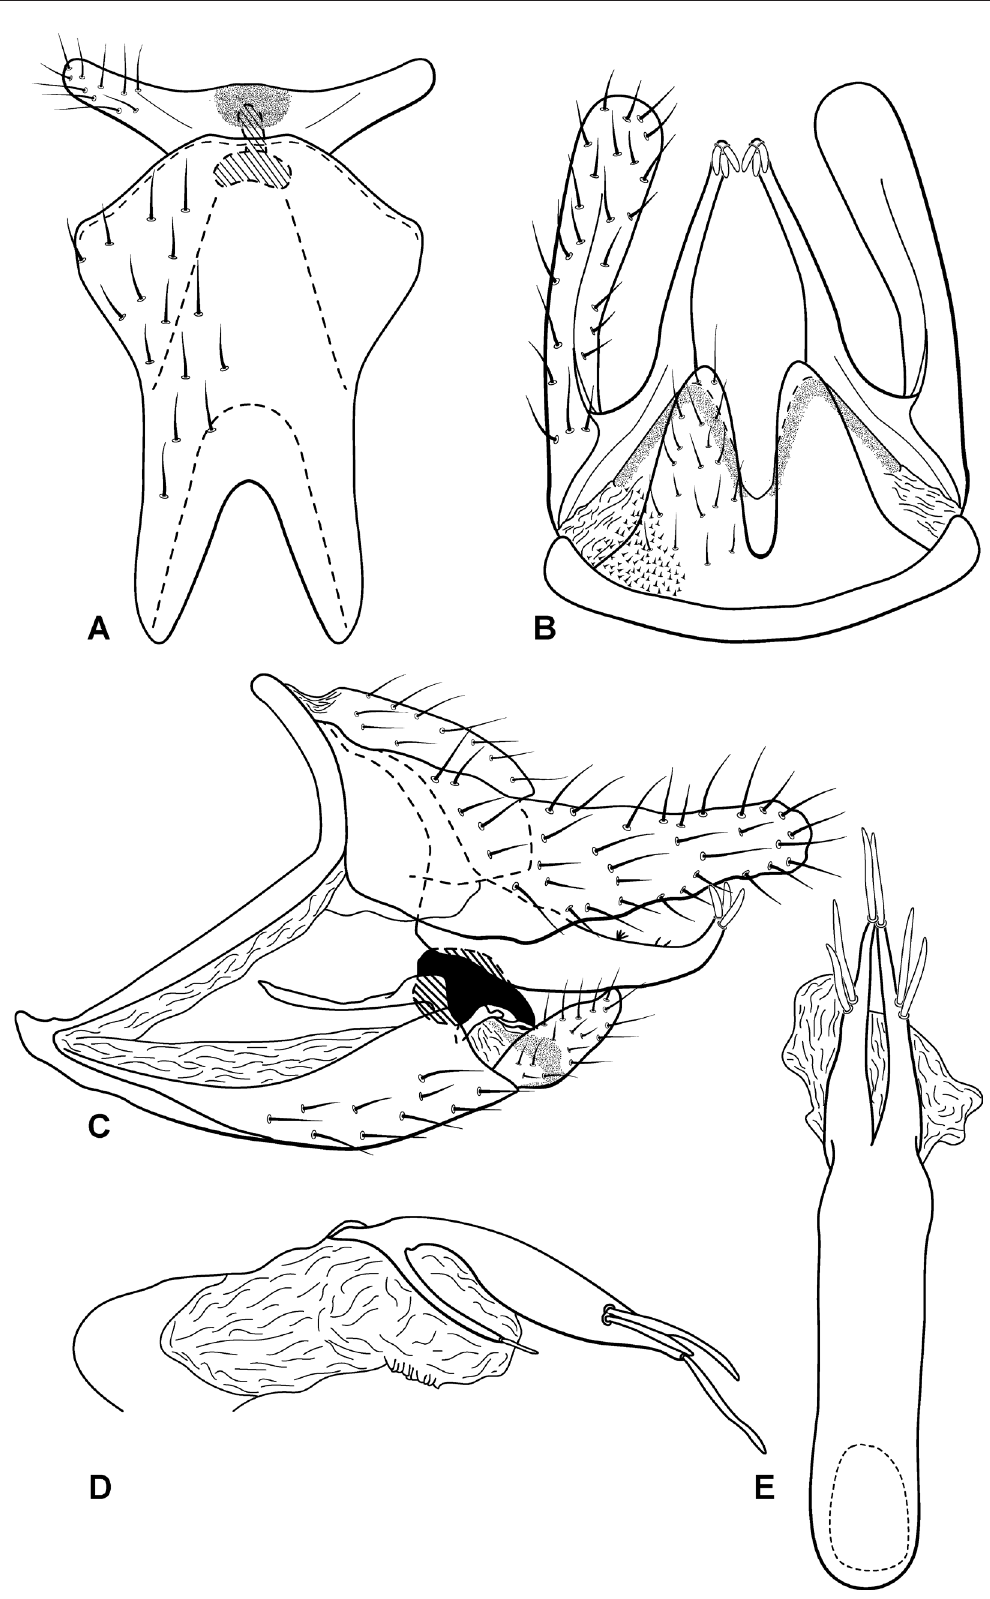
Fig. 8. Austrotinodes gusmaoi sp. nov., male genitalia. A . Ventral view. B . Dorsal view. C . Left lateral view. D . Phallic apparatus, left lateral view. E . Phallic apparatus, dorsal